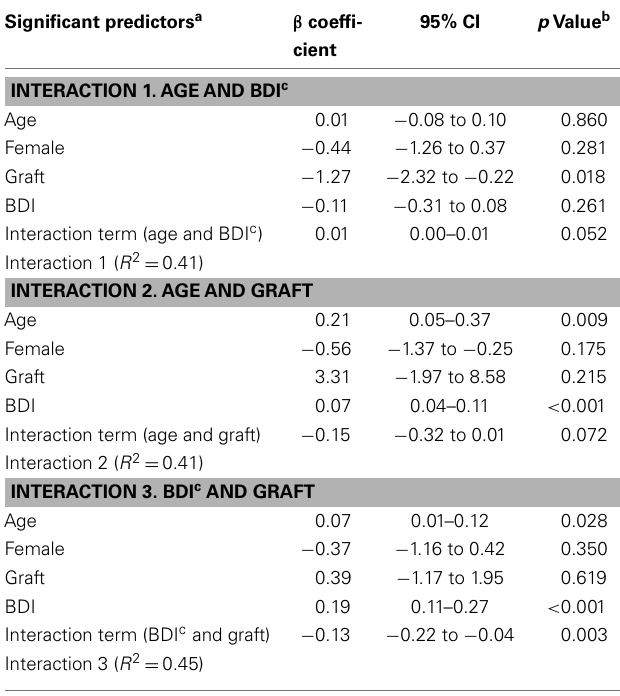
Table 5 | Interaction analysis between pairs of significant predictors of pain